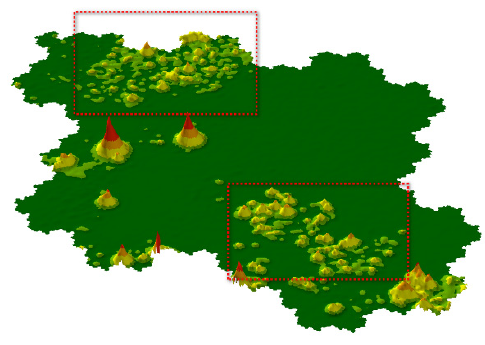
Figure 10. The virtual terrain of ArcGIS Desktop 10.1 produced without the cluster process.